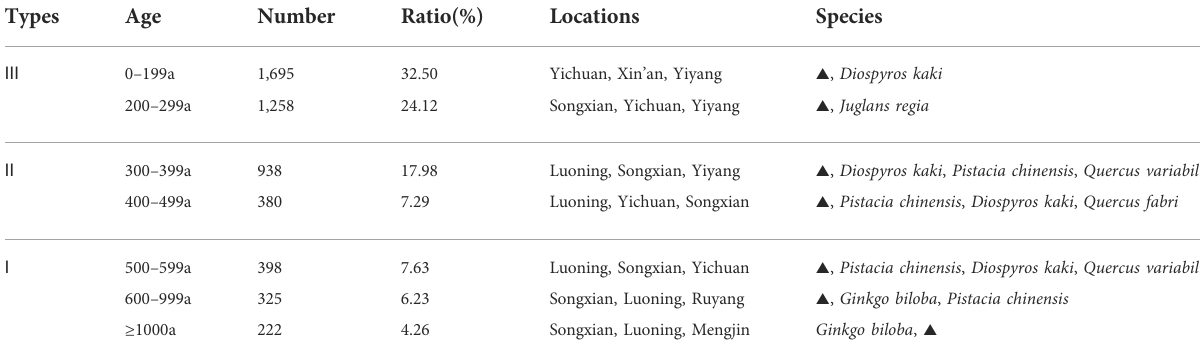
TABLE 2 Categories of heritage trees according to their